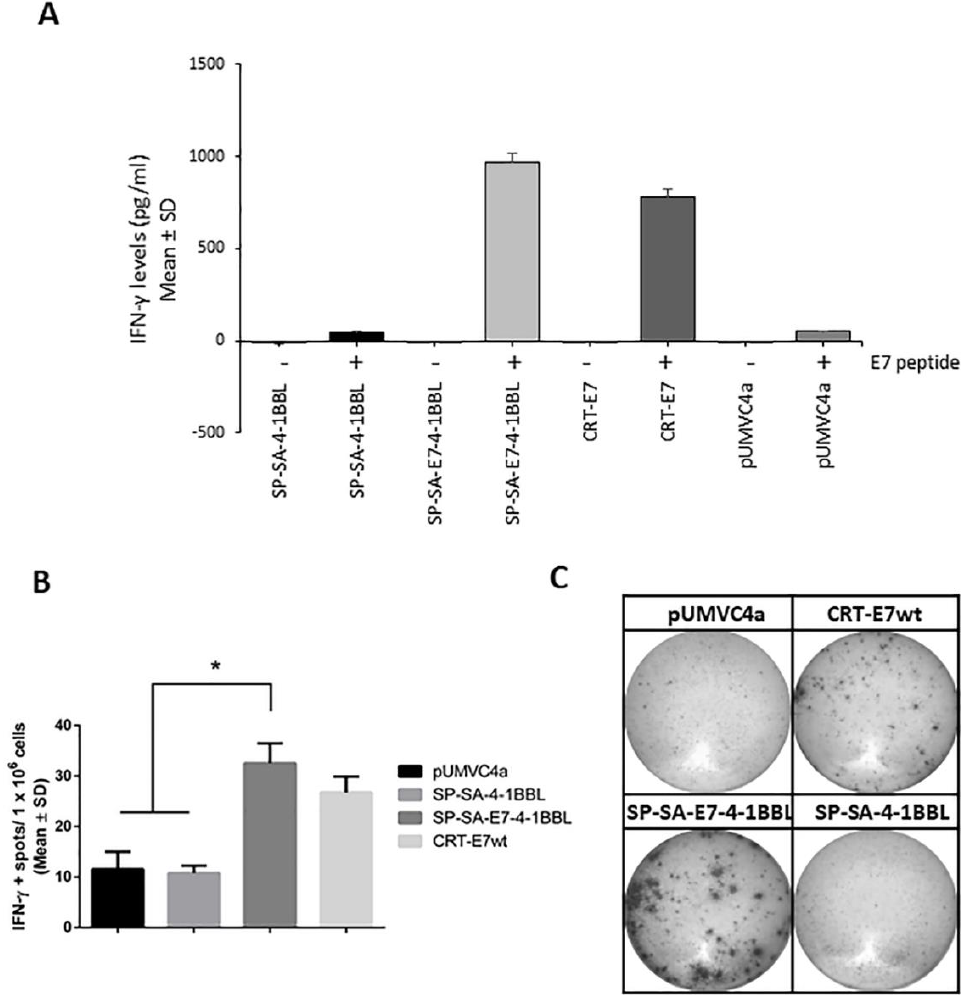
Figure 4. Immunization with SP-SA-E7-4-1BBL DNA vaccine generates E7-specific IFN- γ production: ( A ) C57BL/6 mice were immunized on day 0 and 7 using 1 µg of DNA on shaved abdominal skin by the gene gun system. Splenocytes were harvested 23 days after the last immunization, processed by Ficoll-Paque, and the resultant mononuclear cells were stimulated in ELISA IFN- γ assay with the E7 peptide for 48 h. ( B ) Mice were immunized as described above. Splenocytes were harvested 23 days after the last immunization and were processed as described above and stimulated in an ELISpot IFN- γ assay with the E7 peptide for 48 h. ( C ) Representative well images for each treatment group on the ELISpot IFN- γ assay. * p < 0.05, SP-SA-E7-4-1BBL compared with SP-SA-4-1BBL and empty vector.